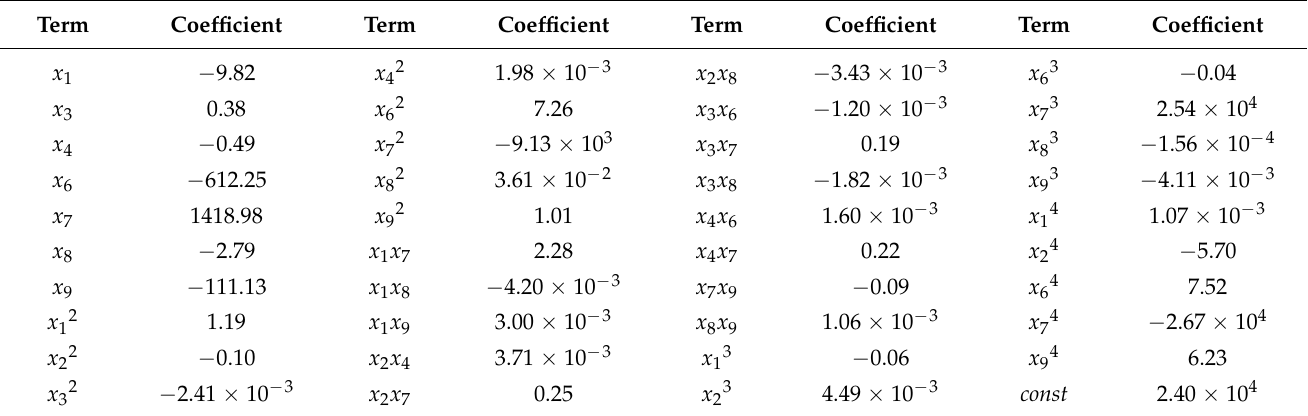
Table 7. Corresponding coefficients for each